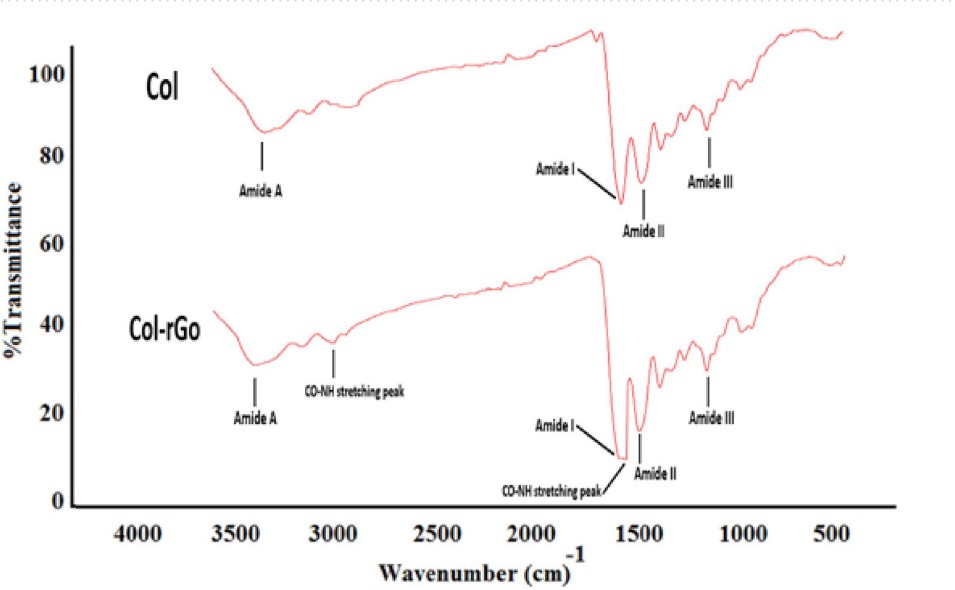
Figure 4. FTIR spectra of the Col and Col–rGO scaffolds, illustrating changes in the functional groups after graphene